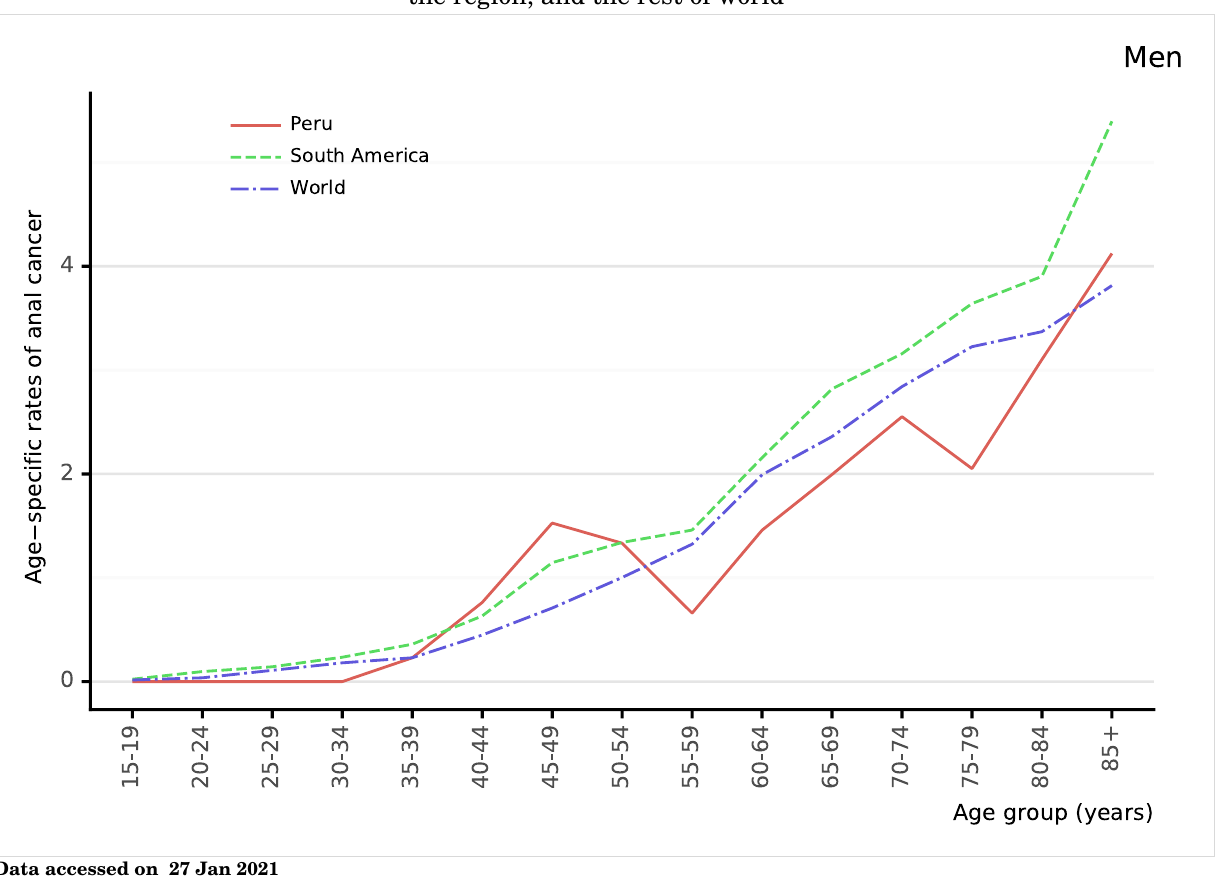
Figure 79: Comparison of age-specific anal cancer incidence rates among men by age in Peru, within the region, and the rest of